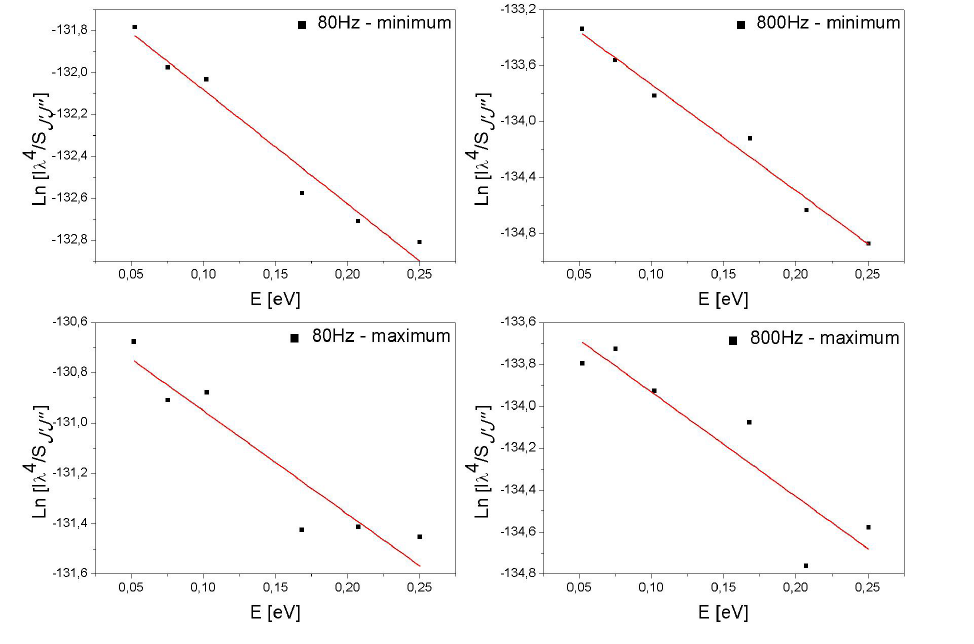
Figure 6 : The selected Boltzmann plots used for calculation of OH rotational temperature in Fig. 5. The graphs are shown for (top left) 80 Hz and ω t = 1.84π, (top right) 800 Hz and ω t = 0.48π, (bottom left) 80 Hz and ω t = 2.72π, and (bottom right) 1697 Hz and ω t = 2.72π.